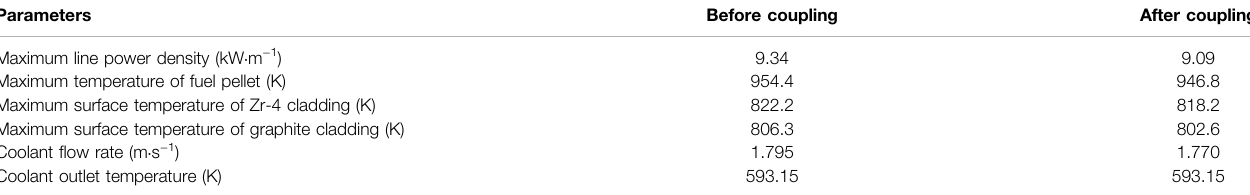
TABLE 3 | Steady-state thermohydraulics parameters of D-4 assembly. Parameters Before coupling After coupling